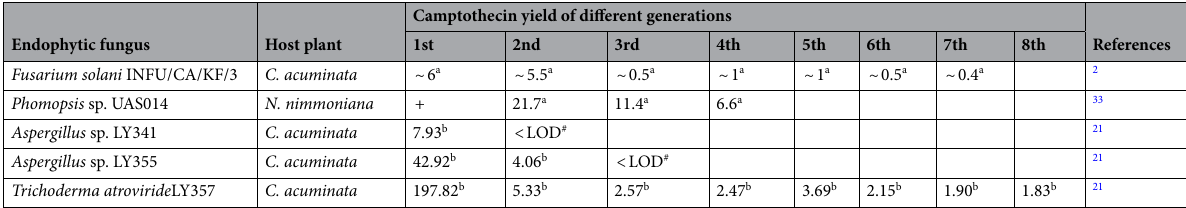
Table 1. Reports on the attenuation of camptothecin produced from endophytes. a μg g −1 ; b μg l −1 ; # LOD limit of detection.